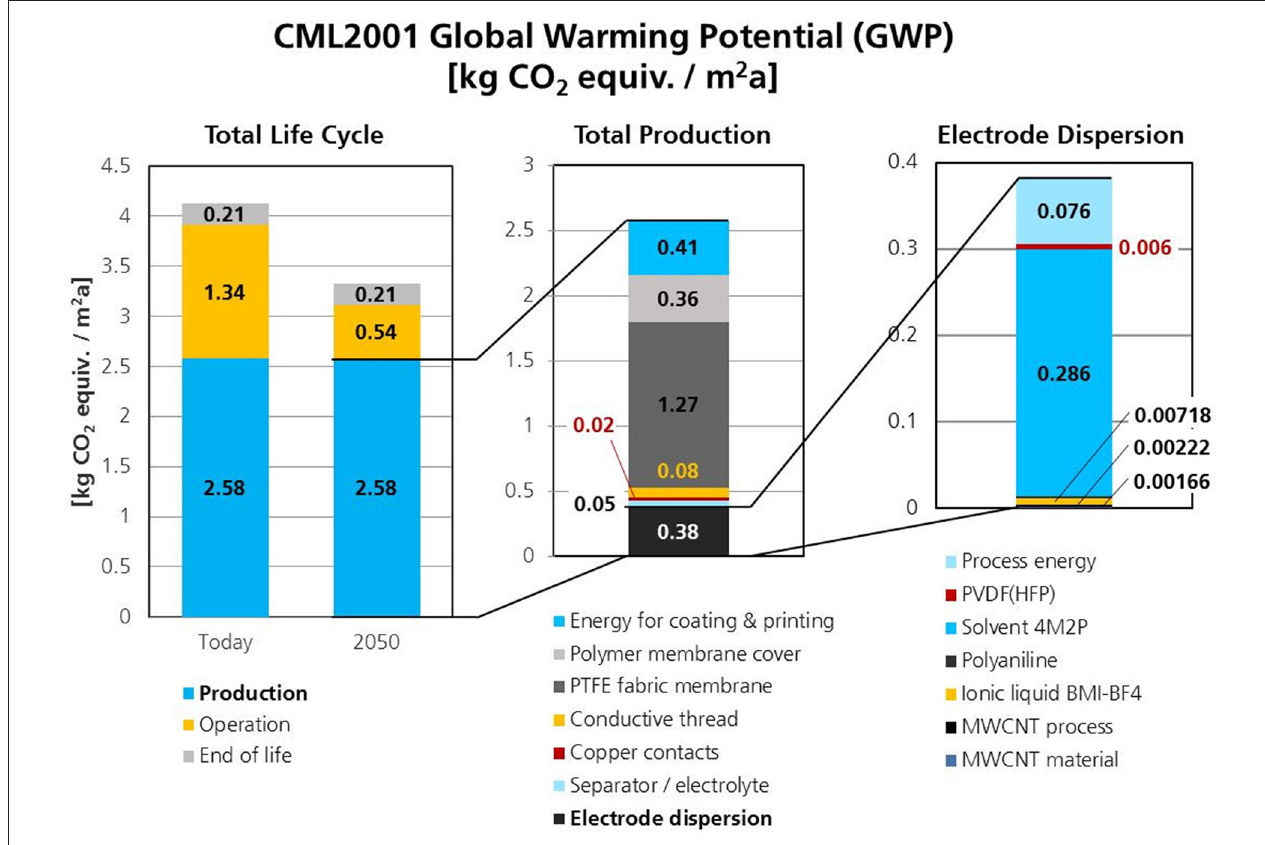
FIGURE 14 | Results of the Life Cycle Analysis (LCA) regarding the energy and material demand required for production, operation and end-of-life treatment of the assembled system. The diagrams show the global warming potential in kilograms of CO 2 equivalents per square meter IEAP-enhanced building skin per year.